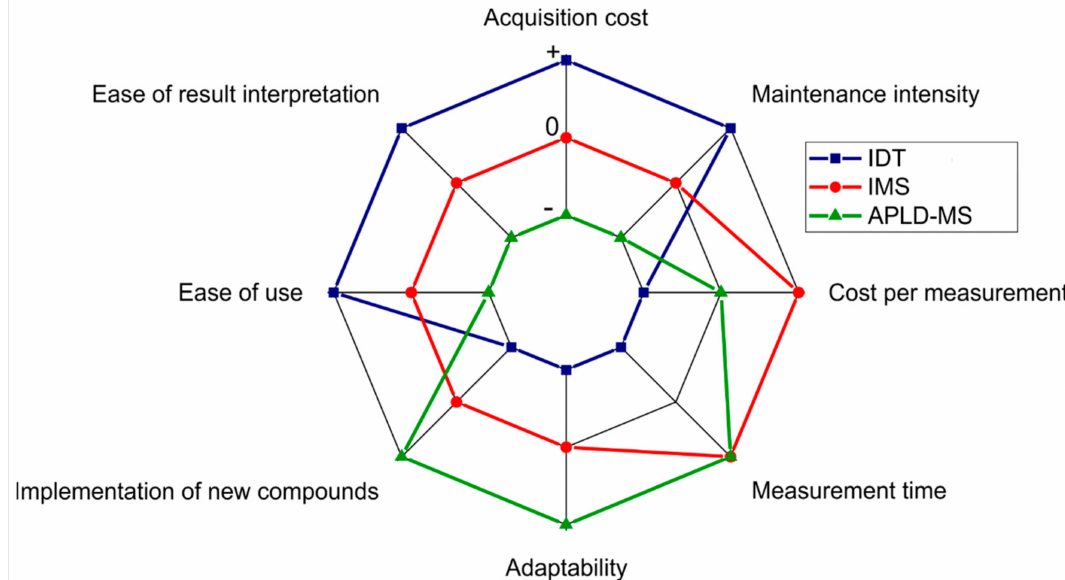
Figure 1. Visualisation of key parameters for the comparison of all three methods. Plus means positive or better, zero means neutral or in between, and minus means negative or worse, in comparison to the other